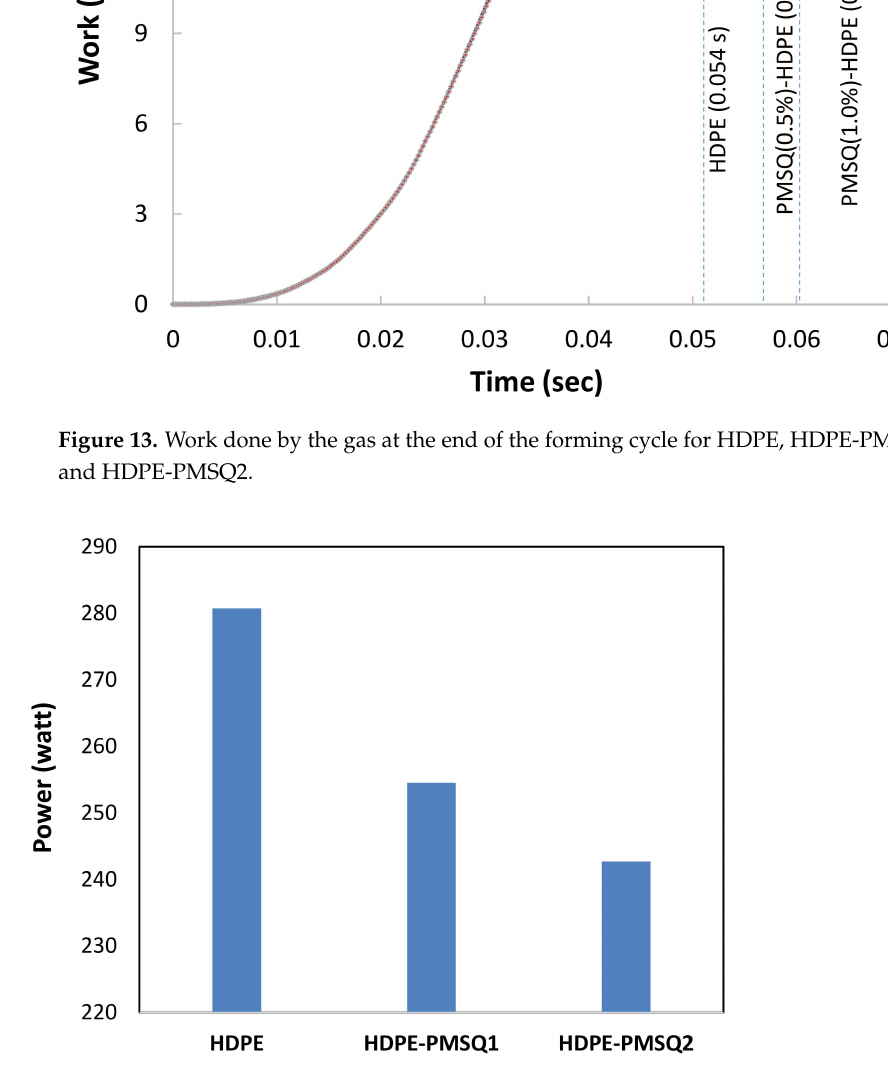
Figure 14. Values of the work at the end of the forming cycle for different formulations of HDPE reinforced with